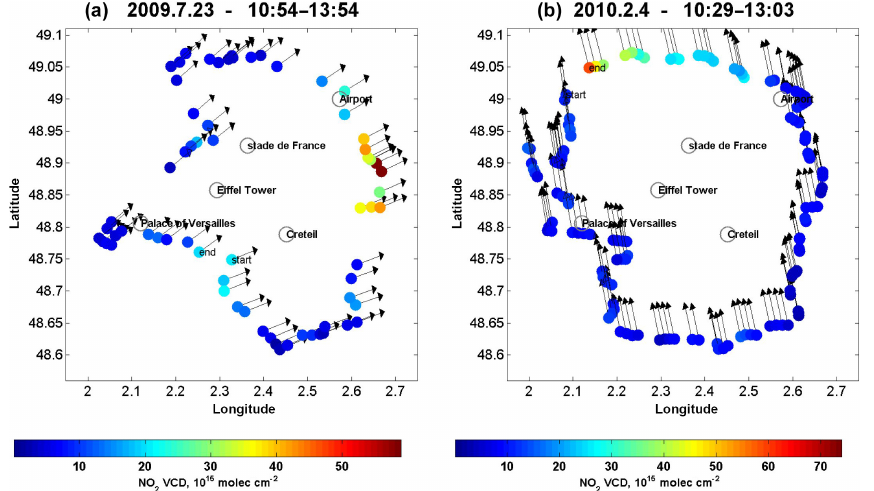
Figure 4. Car MAX-DOAS results for 23 July 2009 (a) and 4 February (b) . On 23 July 2009 several gaps due to instrumental problems occurred. On 4 February, no obvious gap is seen, but a large difference in the NO 2 VCDs between the start and end of the circle is